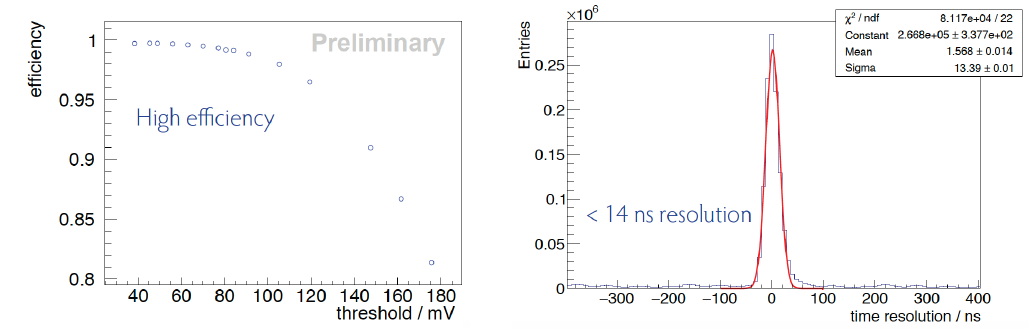
Figure 7: Performance of the MuPix8 pixel sensor prototype: efficiency (left) and time resolution (right) obtained in testbeam